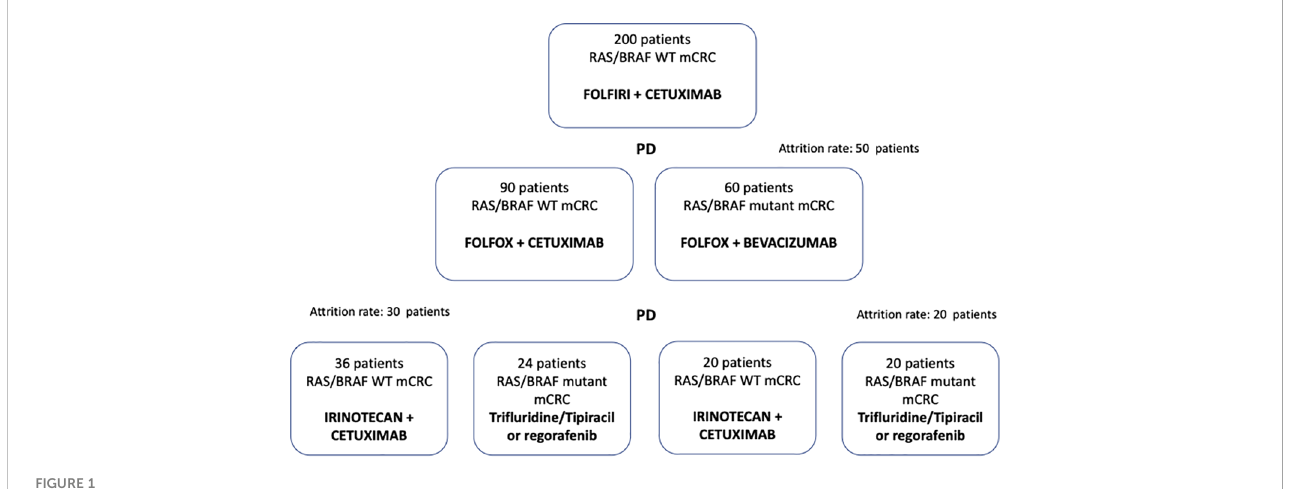
FIGURE 1 Capri 2 GOIM clinical trial consort